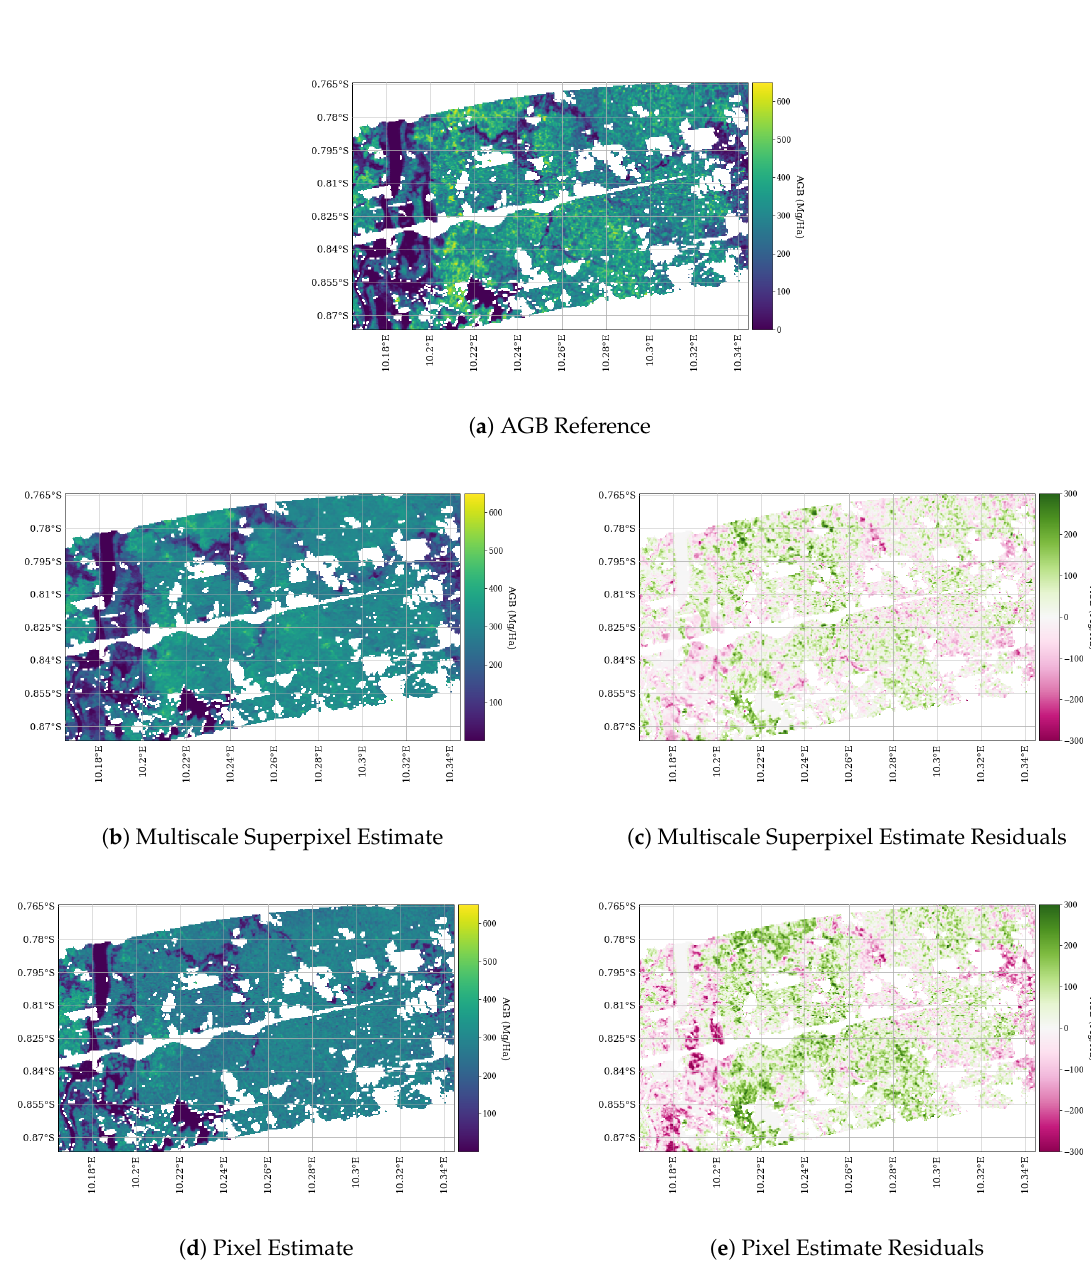
Figure 12. Comparing the AGB reference map (top row) with those derived from multiscale superpixels (second row) and with those derived from pixels (bottom row) on a subset of Ogooue. Model is trained on and applied to full AGB